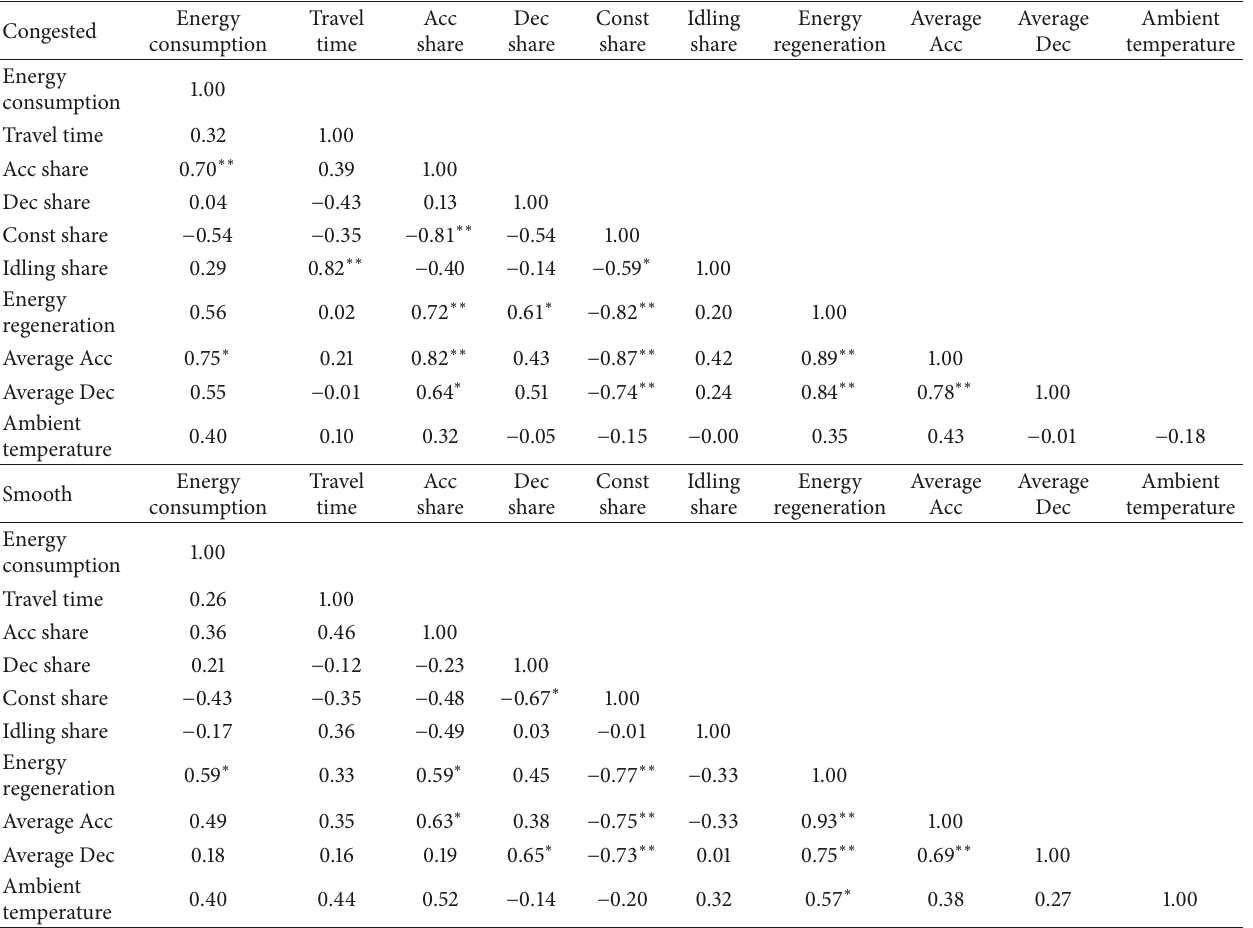
Table 2: Pearson’s correlation coefficients for various trip attributes, by road traffic